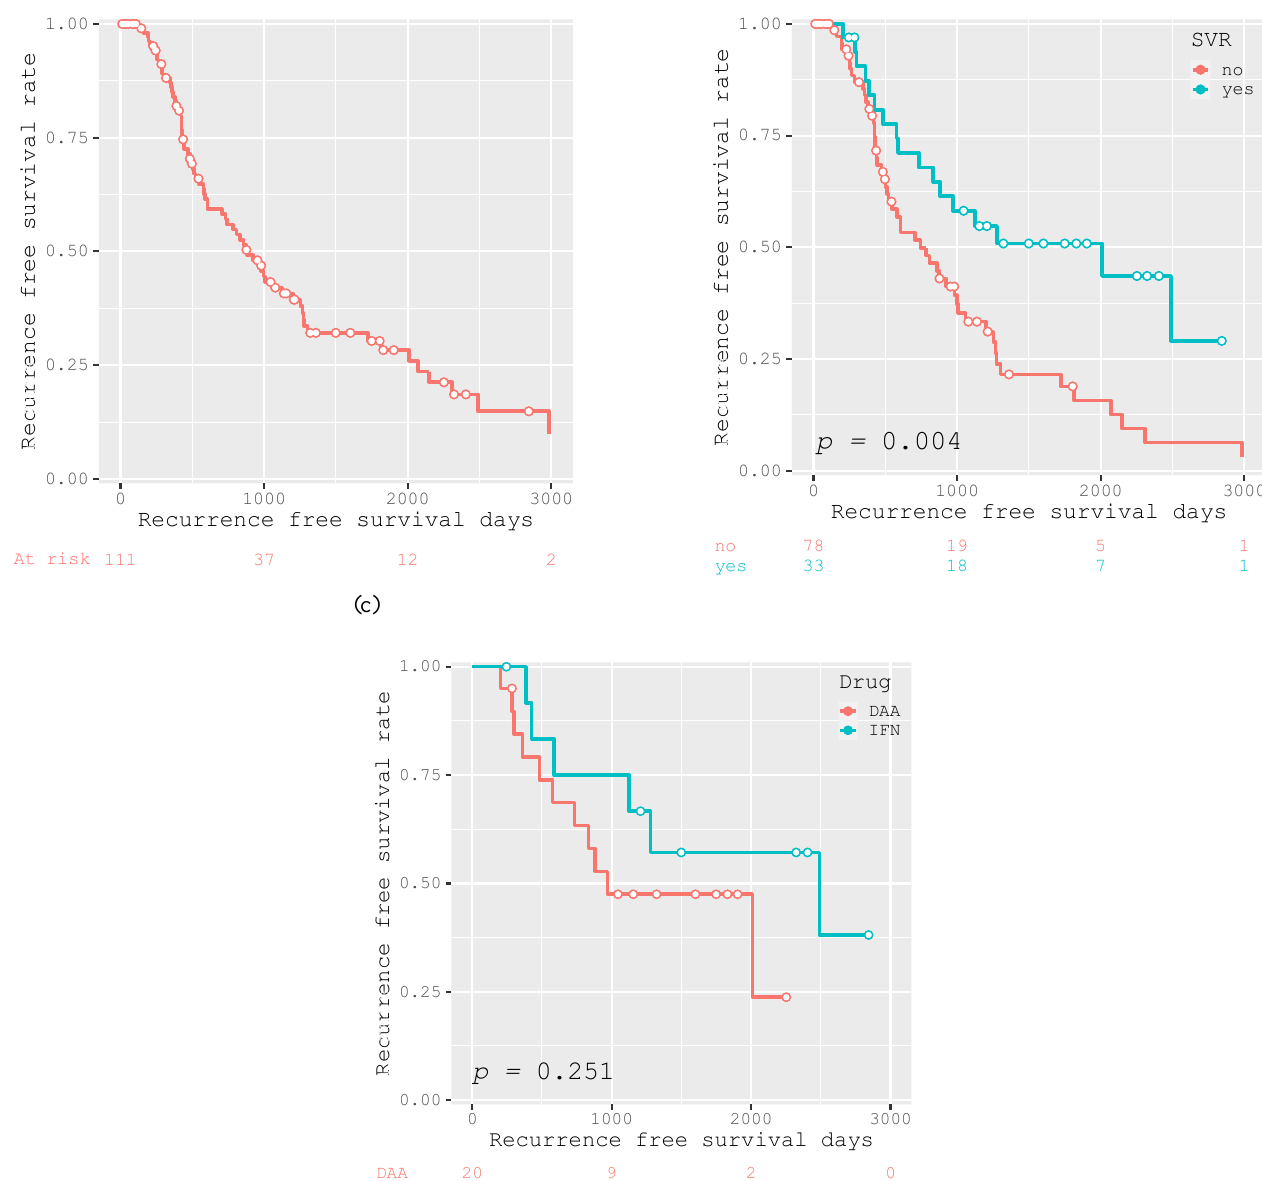
Figure 4. Kaplan–Meier curves for recurrence-free survival after curative treatment for all participants ( n = 111) ( a ), for participants divided into two groups according to SVR achievement ( n = 33) or not ( n = 78) ( b ), and for the 33 participants achieving SVR who were divided according to antiviral therapy with DAA ( n =20) or IFN ( n =13) for HCV ( c ). Among the patients who achieved SVR, there was no significant difference in the RFS rate between patients with AFP levels ≥11 ng/mL and <11 ng/mL ( p = 0.362; Figure 5a). On the other hand, among the patients who did not achieve SVR, those with AFP levels ≥11 ng/mL had significantly poorer RFS than those with AFP levels <11 ng/mL ( p < 0.001; Figure 5b).